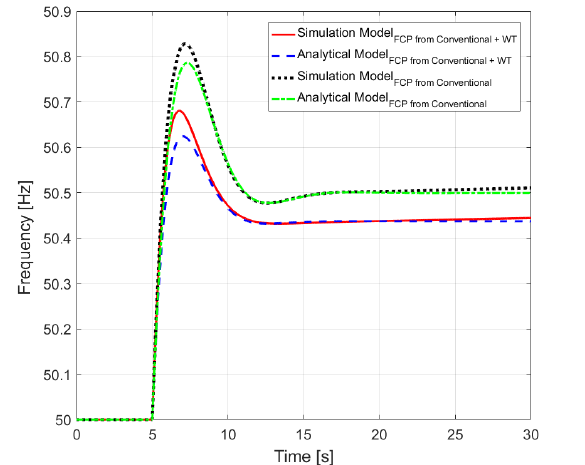
Figure 16. Analytical and Simulation Model for 10% wind